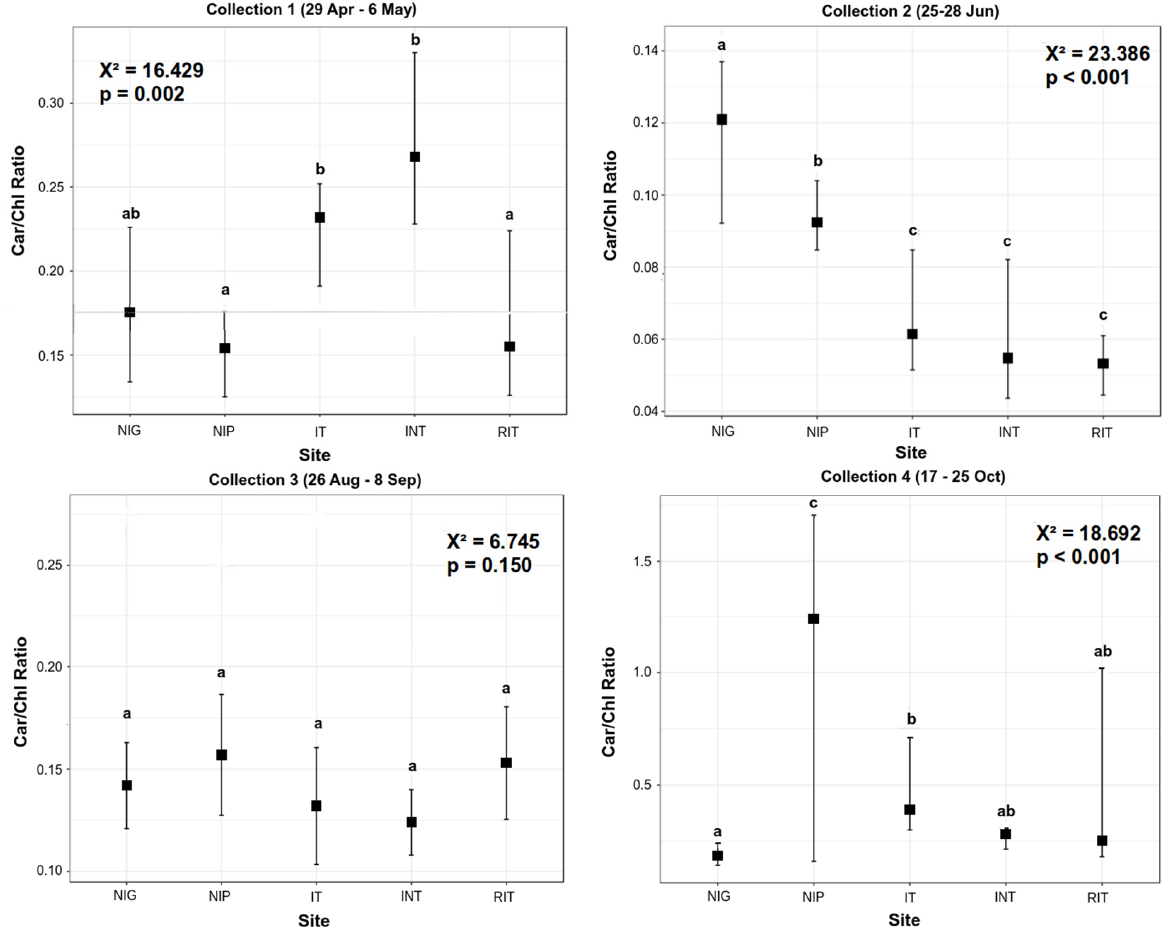
Figure 6. Kruskal–Wallis test results for Car/Chl ratio in 2017. Letters indicate groupings determined by the Conover–Iman test with Bonferroni adjustment. Codes for each site are given in Table 2. Whiskers indicate the range of the data. Note that data ranges were selected to show variation within the data sets, are not uniform between each panel of the diagram.